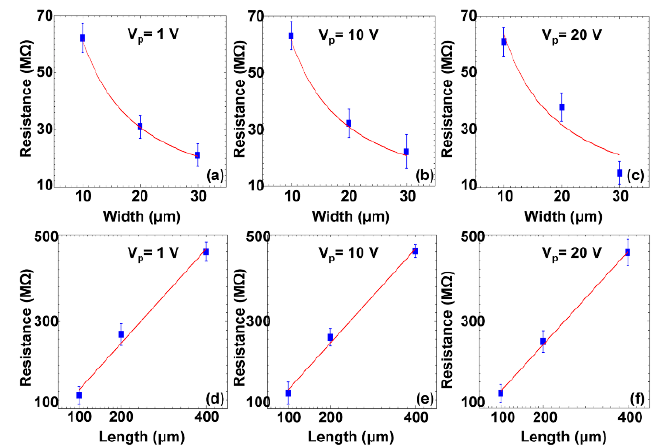
Figure 10. The curve-fitting function of the assembled carbon nanoparticle (CNP)-based microstructures. Resistance with respect to different widths of three microstructures at three different measurement voltages ( a – c ); Resistance with respect to different lengths of three microstructures at three different measurement voltages ( d – f ) (reproduced from Ref. [74]).